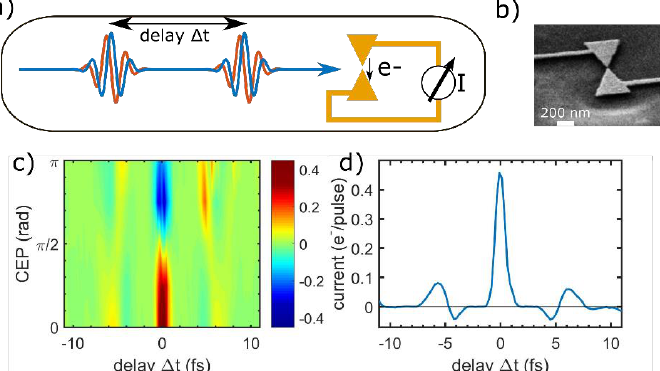
Fig. 1. (a) Conceptual sketch of the experiment with two single-cycle light pulses at delay time Δt focused on the nanogap of the circuit. The carrier-envelope phase of the biasing pulses can selected arbitrarily. (b) Scanning electron micrograph of the nanocircuit employed in the experiments, consisting of an Au optical antenna with electrical leads on a fused-silica substrate. (c) Colormap of nanotunneling current as a function of delay between the two driving pulses and as a function of their carrier-envelope phase. (d) Autocorrelation trace as a function of time delay Δt measured for a carrier-envelope phase of 0 (i.e. cosine-like pulses), corresponding to maximum total